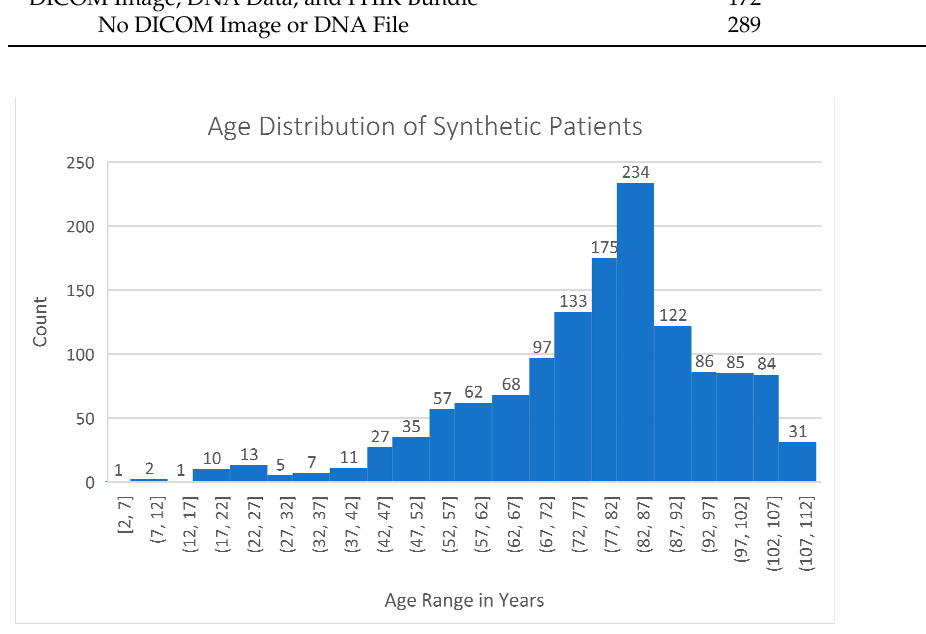
Figure A2. Distribution of synthetic patients by age group and sex. 0 20406080 100